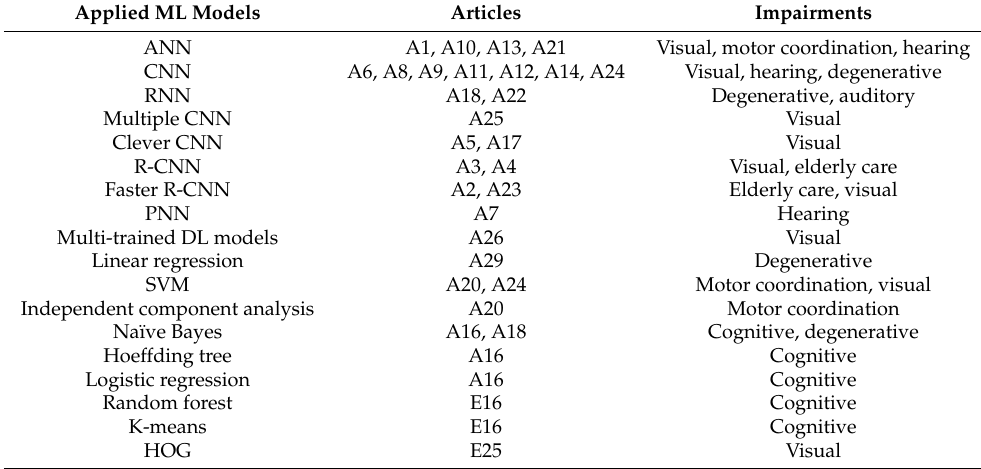
Table 9. Algorithms and machine-learning techniques applied, and the respective deficiency ad- dressed for each